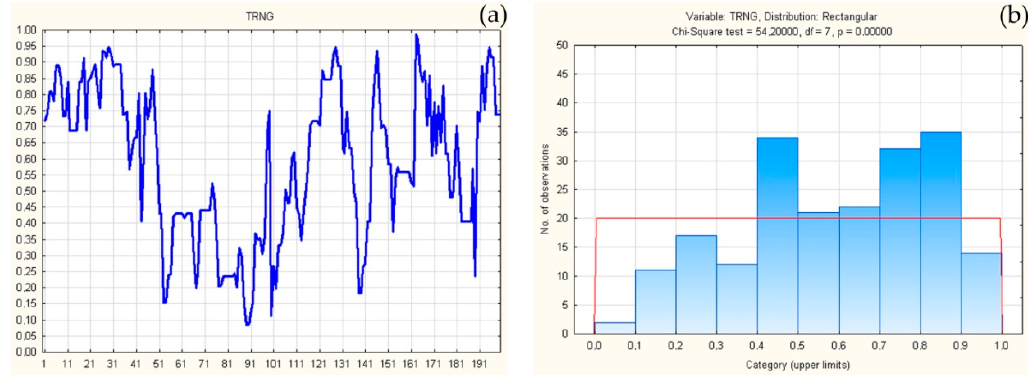
Figure 7. Exponential distributions of all 200 sets Δ↓ [TRNG(i)] ( a ), verifications, and distribution of verifications ( b ).